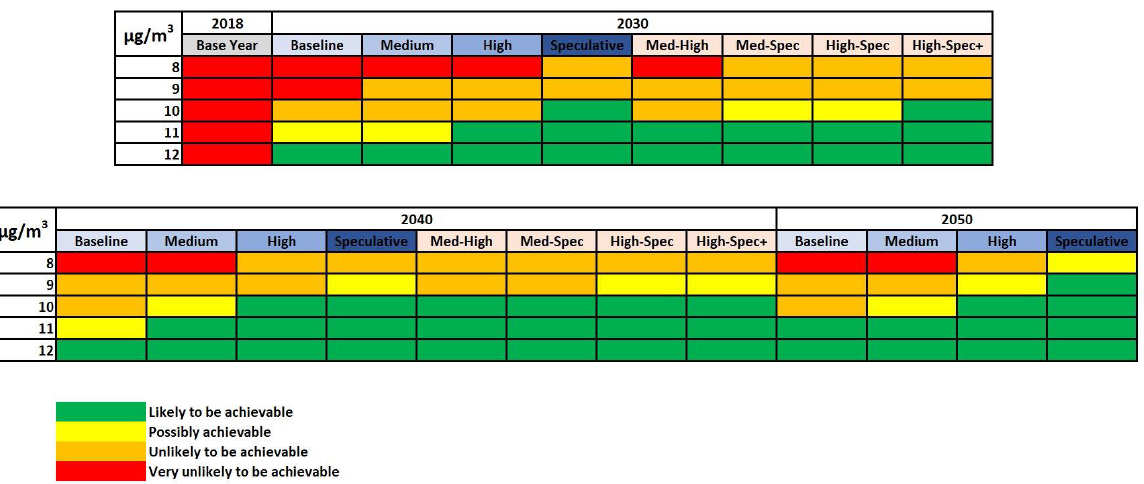
Figure 9. Risk of exceedance Traffic Light Matrix of feasible targets for each scenario and year modelled, highlighting the degree of ambition needed to reach the target concentrations. The base year is shown in grey, the alternative scenarios are shown from light blue (baseline) to dark blue (speculative), and the combined scenarios shown in pink and reflect, for example, for “High-Spec”, the high scenario applied nationally with the speculative scenario applied in London.